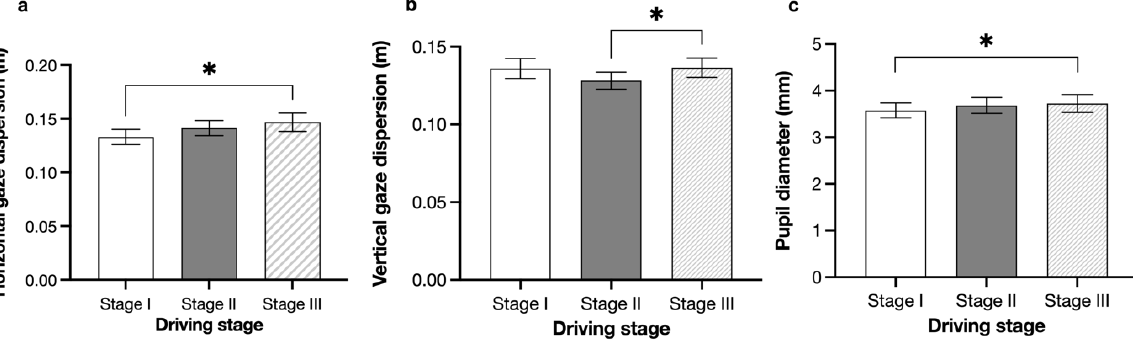
Figure 8. Eye tracking indicators under three driving stages. (Note: ( a ) represented analysis of drivers’ horizontal gaze dispersion; ( b ) represented analysis of drivers’ vertical gaze dispersion; ( c ) represented analysis of drivers’ Pupil diameters. A single asterisk (*) indicates significance at p < 0.05).